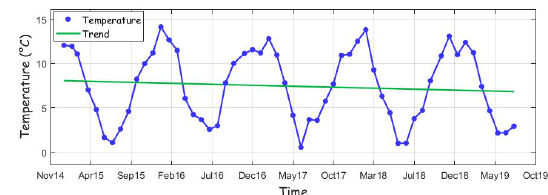
Figure 13. Monthly mean air temperatures from 2 meters (blue line and circles) from January 2015 to August 2019 and its trend line